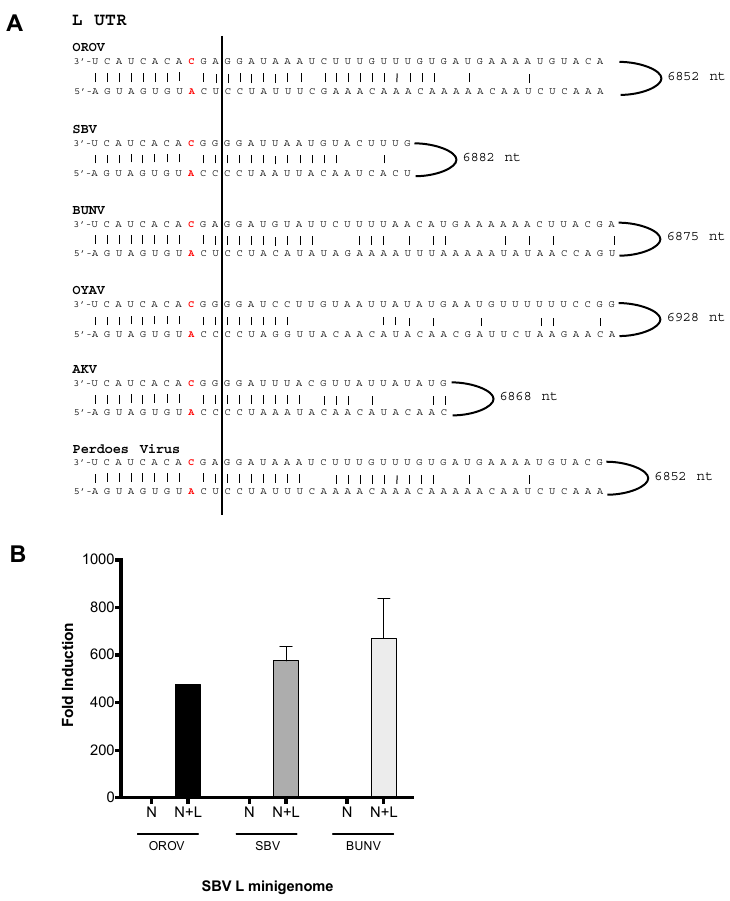
Figure 4. Analysis of Simbu large segment untranslated region (L UTR). ( A ) Sequence comparison of the 3 ′ and 5 ′ panhandle nucleotides of the L segments from Oropouche virus (OROV) (GenBank Accession no. KP052850), Schmallenberg virus (SBV) [18], Bunyamwera virus (BUNV) (GenBank Accession no. NC_001925), Oya virus (OYAV) (GenBank Accession no. JX983194), Akabane virus (AKV) (GenBank accession no, NC_009894) and Perdoes virus (GenBank Accession no. KP691627). All viruses contain a single mismatch at position nine (8 A/U 9 C/A ). These mismatches have been highlighted in red in the sequence alignment. ( B ) Minigenome assays. BSR-T7/5 cells were transfected with OROV N-L, or SBV N-L, or BUN N-L (250 ng), and TVT7RSBVLRen(-) (125 ng) and pTM1-FF-Luc (40 ng). At 24 h p.t., luciferase activity was measured and calculated and described above. Error bars indicate SD ( n = 3).